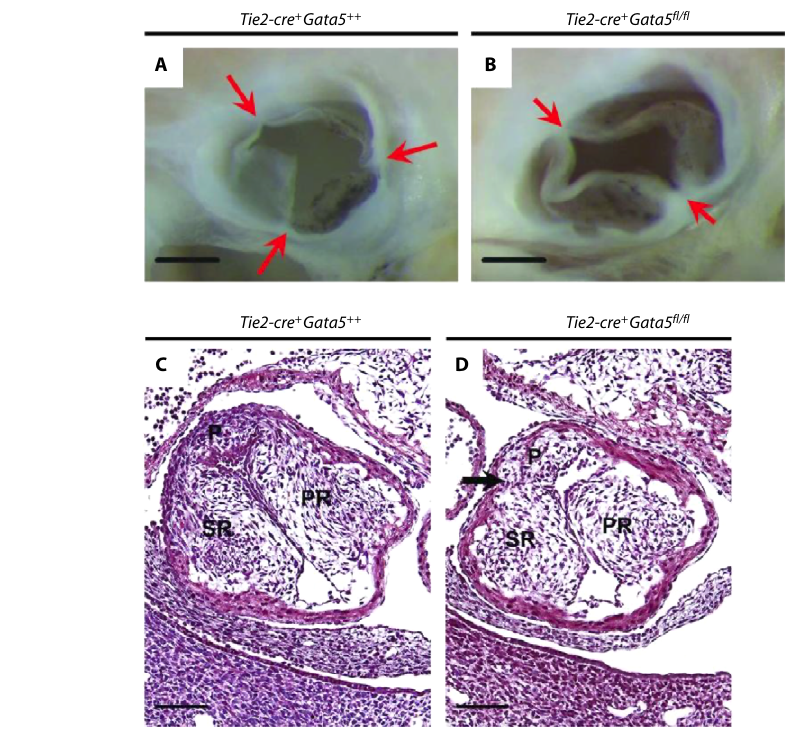
Figure.4 Gata5 isrequiredforaorticvalveformation. (AandB)AnatomicanalysisrevealsthepresenceofBAVin Tie2-cre + Gata5 fl / fl mice.Arrowspointtoanattachmentofthevalvecupstotheaorticwall.(CandD)Histological analysis of the outflow tract of (C) wild type, and (D) Tie2-cre + Gata5 fl / fl mutant at E11.5. Arrow shows abnormal fusion resulting in an R-N BAV. Figure reproduced with permission from